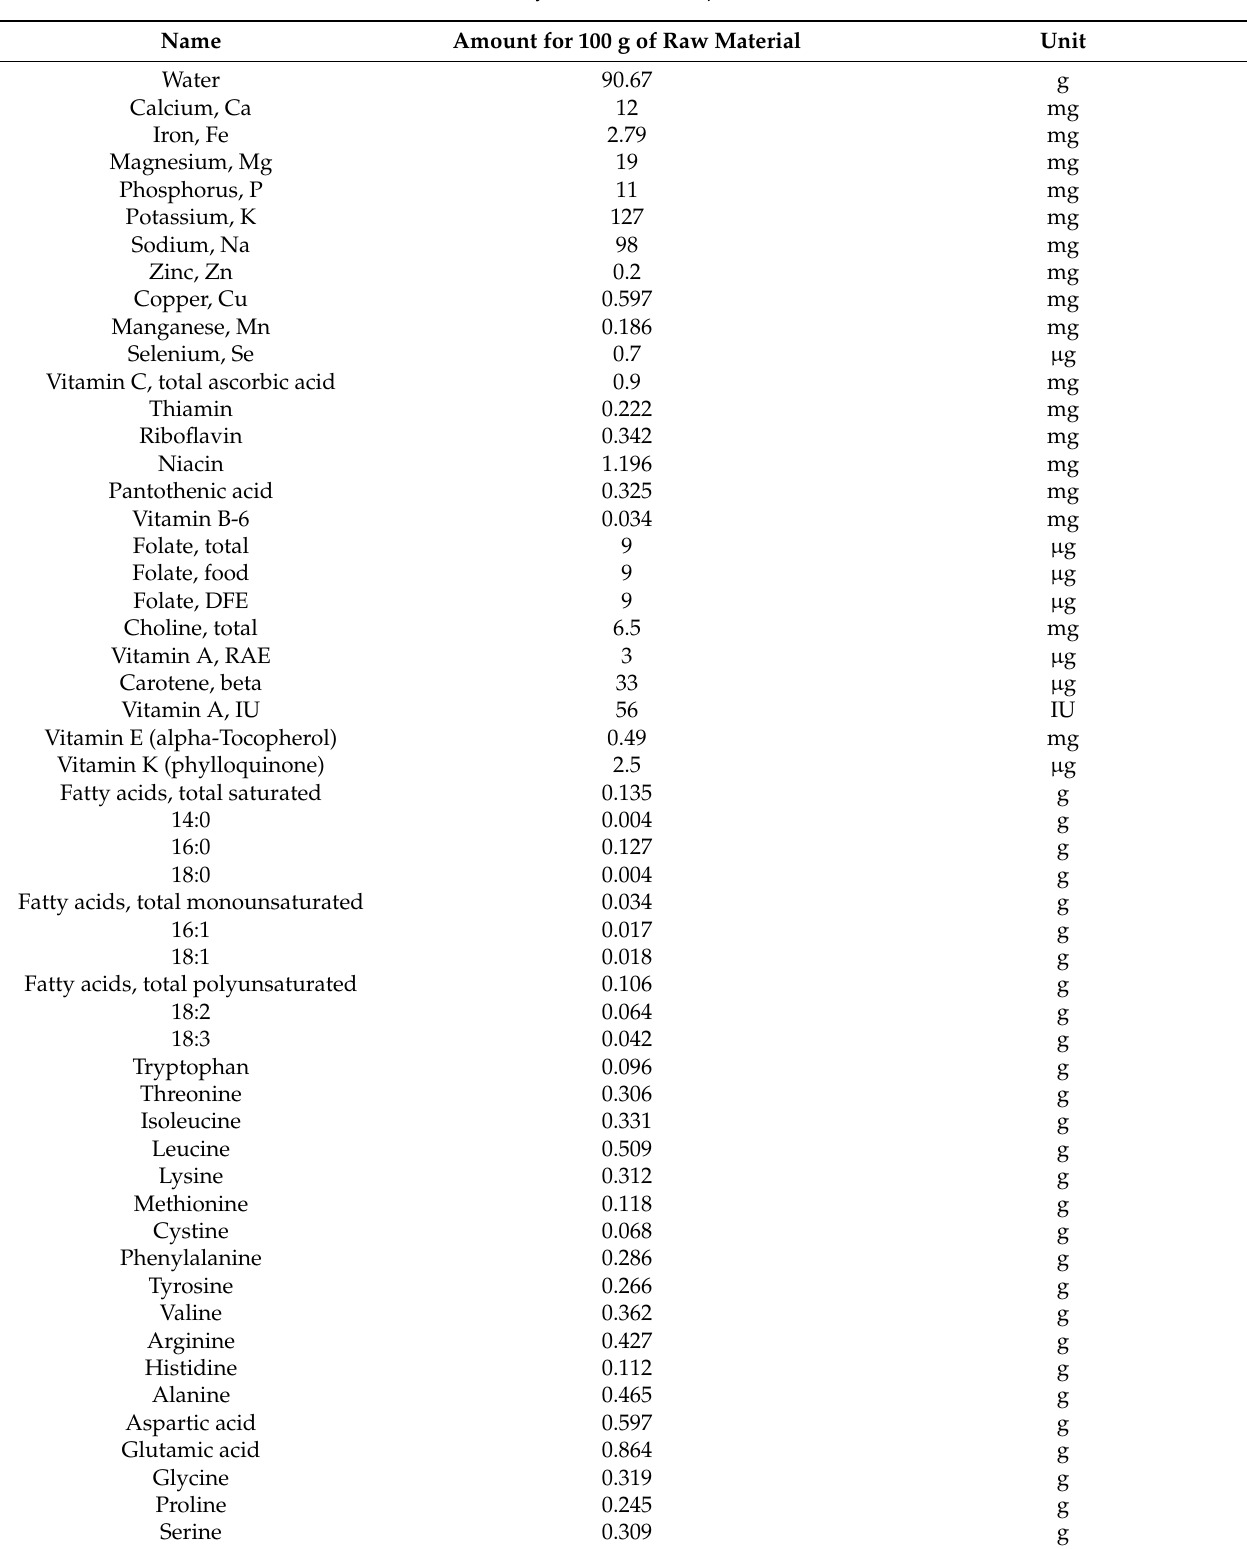
Table 1. Phytochemicals of Spirulina